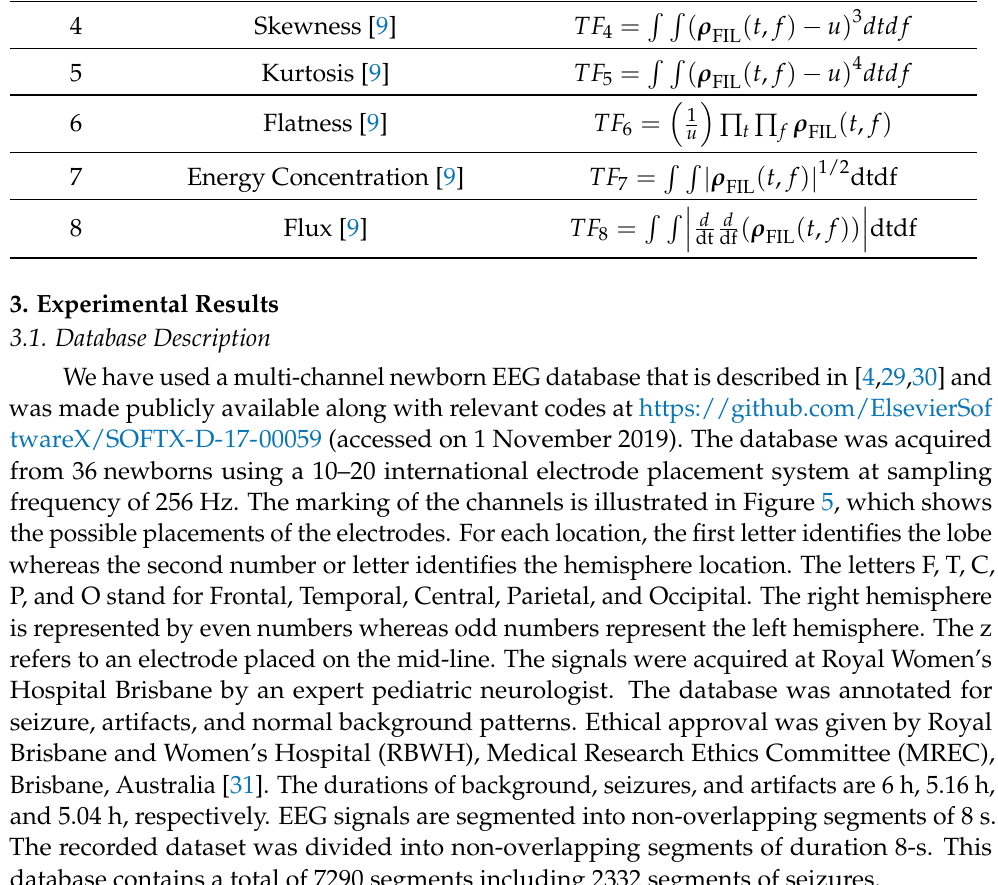
( t , f ) . ( c ) TF signature of FIL